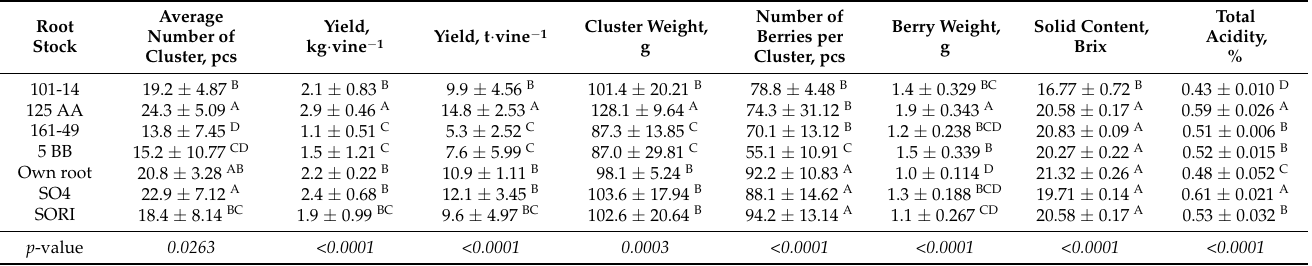
Table 1. Influence of rootstock type on the quantity and quality of the Regent grapevine